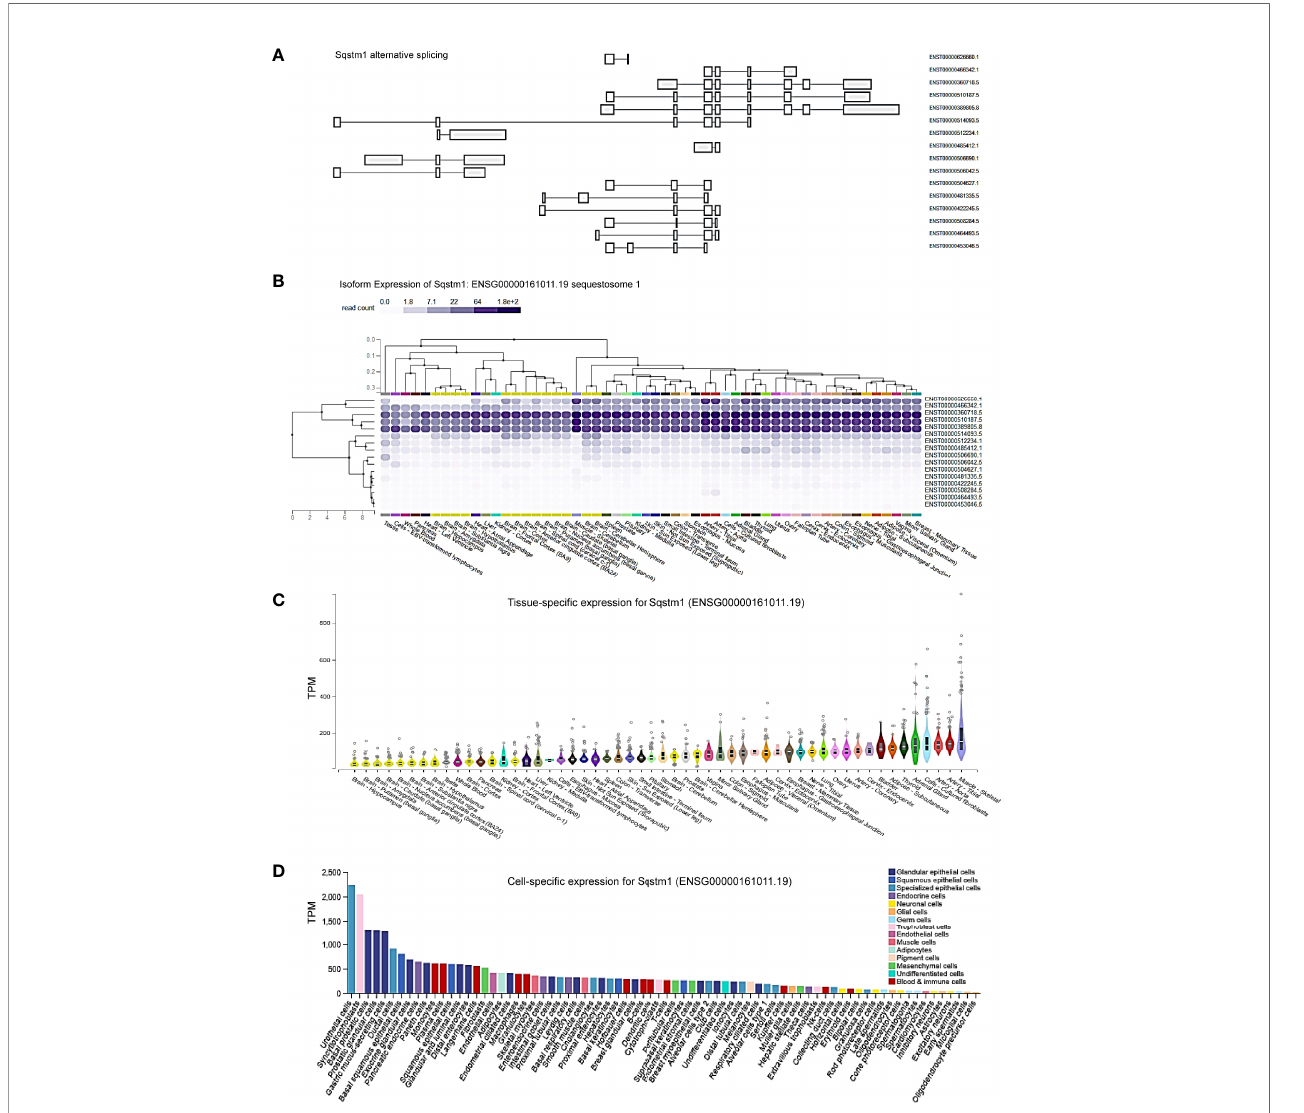
FIGURE 1 | Tissue- and cell-speci fi c expression of Sqstm1. (A) Sixteen splicing variants of Sqstm1 primary transcript, nine of which encode proteins, with the dominant transcript ENST00000389805 encoding a protein of 440 aa in length. (B, C) Tissue- and cell-speci fi c expression of Sqstm1 splicing variants, respectively. Total transcript of Sqstm1 gene (ENSG000000161011) is shown. (D) Cell-speci fi c expression of Sqstm1 transcript. (A – C) are the results from GTEx portal, and (D) from ProteinAtlas portal. TPM, transcripts per million; NX, denoted normalized expression. Read counts and TPM values were generated with RNA-SeQC v1.1.9